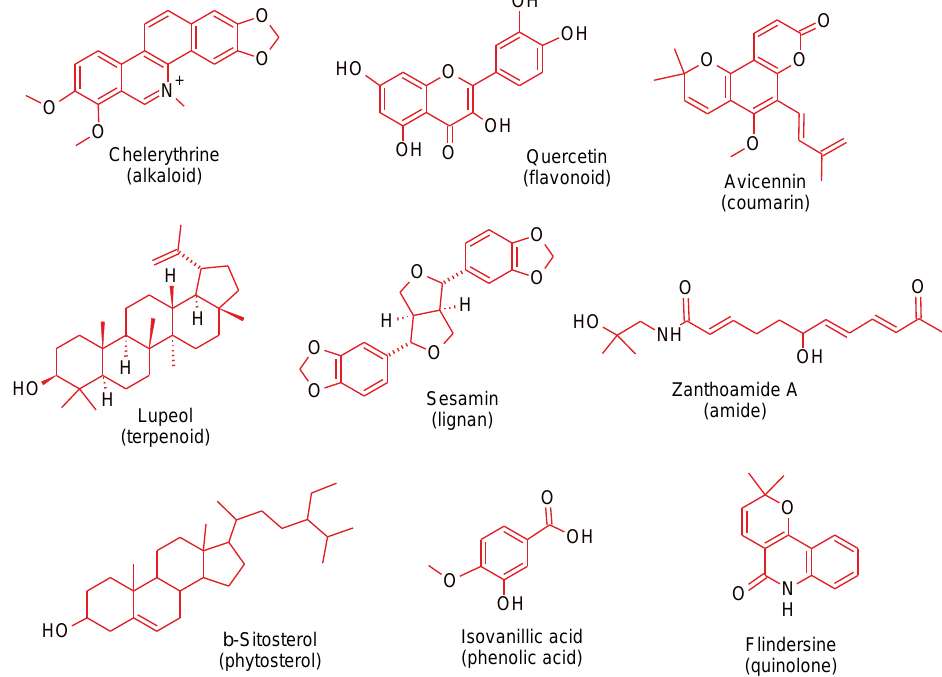
Figure 1. Representative compounds from the different classes of phytochemicals isolated from Zanthoxylum species.